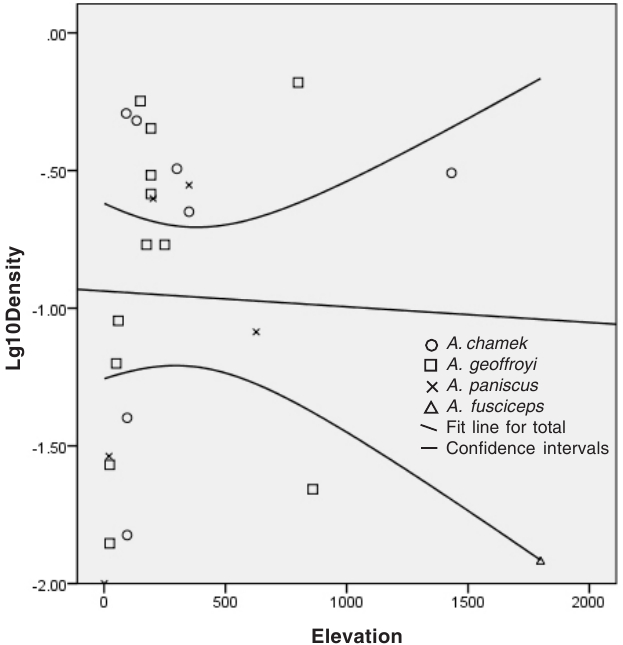
Figure 1. Regression of log spider monkey density against